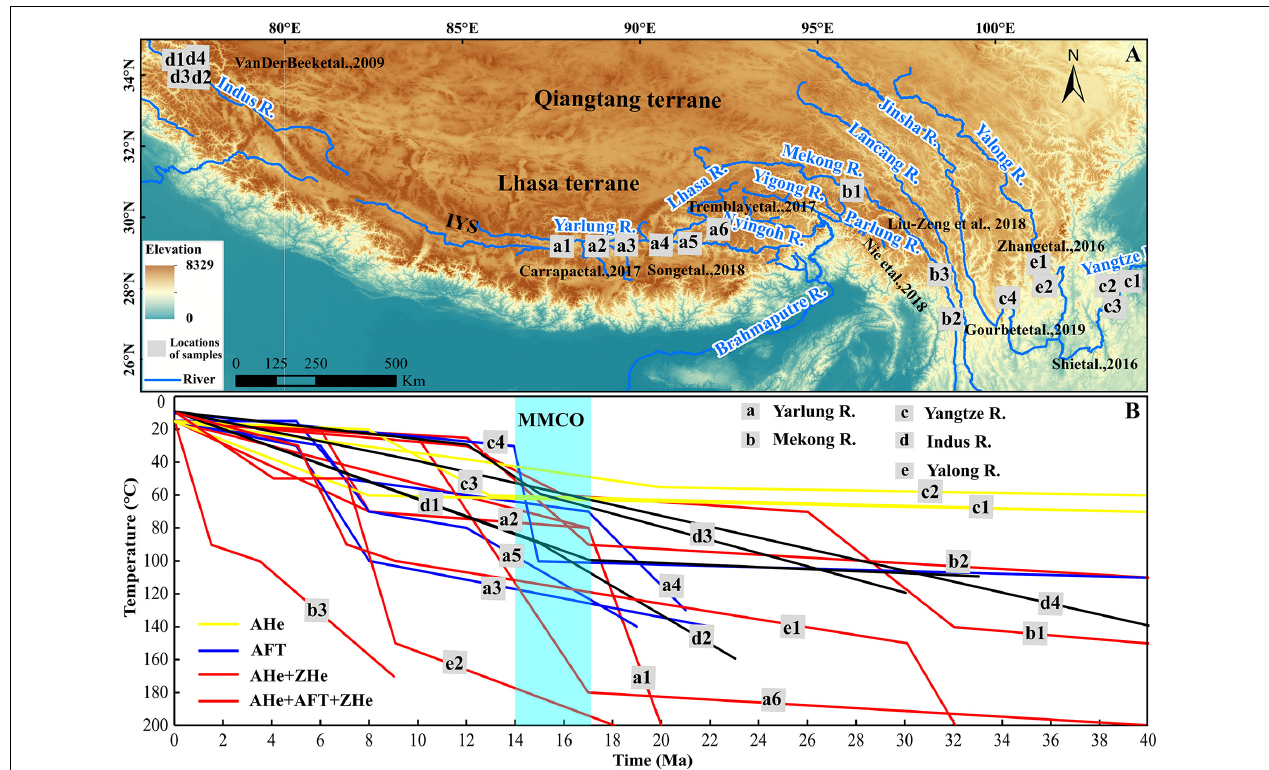
FIGURE 8 | Cooling history of large rivers in the southern Tibet Plateau retrieved by Hefty (Ketcham, 2005) or QtQt (Gallagher, 2012). (A) Sampling sites of the river detrital or bedrock low-temperature thermochronology in the southern Tibetan Plateau. The letters a, b, c, d, and e represent the study sites of the Yarlung River, Mekong River, Yangtze River, Indus River, and Yalong River, respectively. (B) 2D thermal history modeling (Hefty or QtQt) results of thermochronological ages from the large rivers in the southern Tibetan Plateau (data from van der Beek et al., 2009; Tremblay et al., 2015; Shi et al., 2016; Zhang et al., 2016; Carrapa et al., 2017; Nie et al., 2018; Song et al., 2018; Liu-Zeng et al., 2018; Gourbet et al., 2019). MMCO, middle Miocene climate optimum.